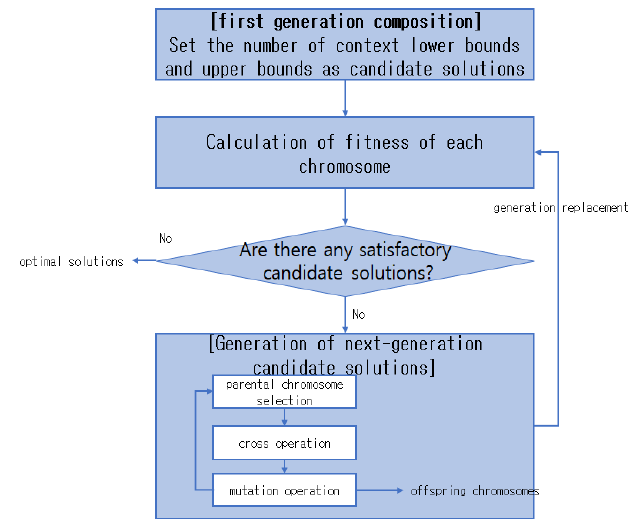
Figure 6. Flowchart of GA process.